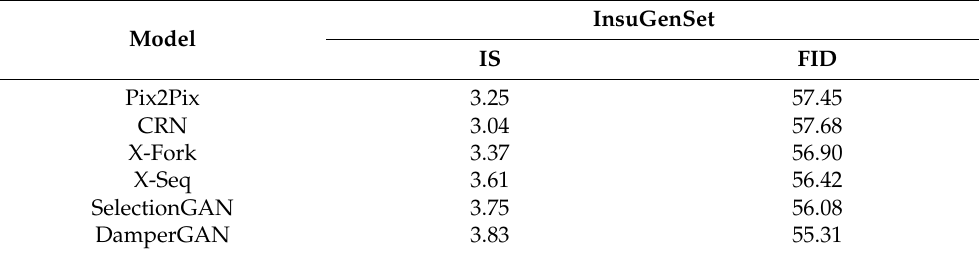
Table 3. IS and FID of the different